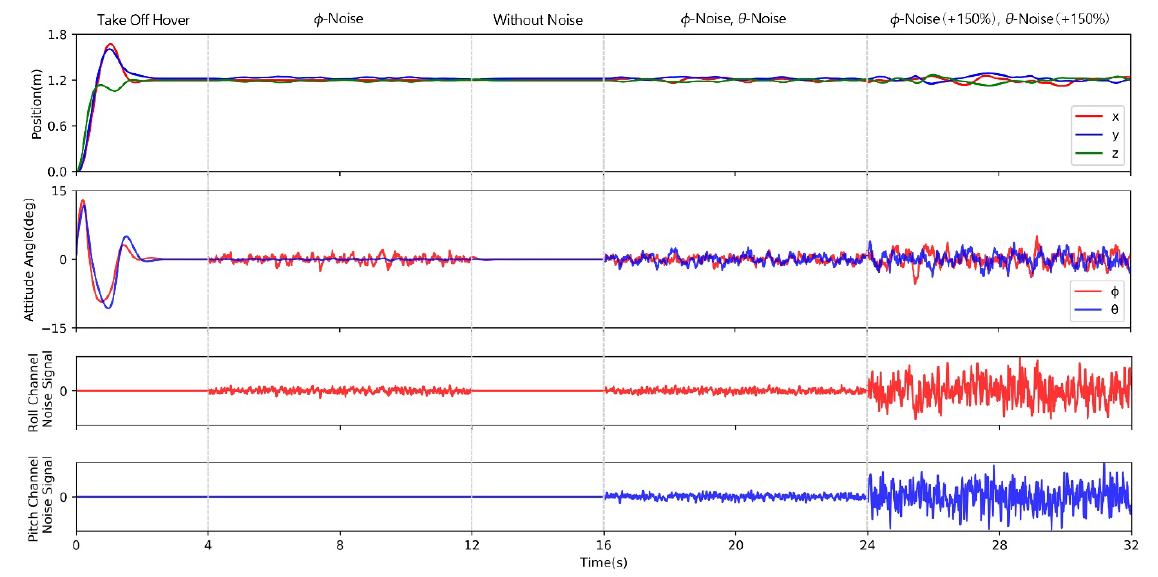
Figure 17. Position and attitude of quadrotor under noise disturbance.